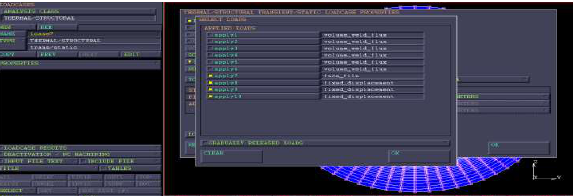
Figure 5 Working condition setting pattern of the cooling